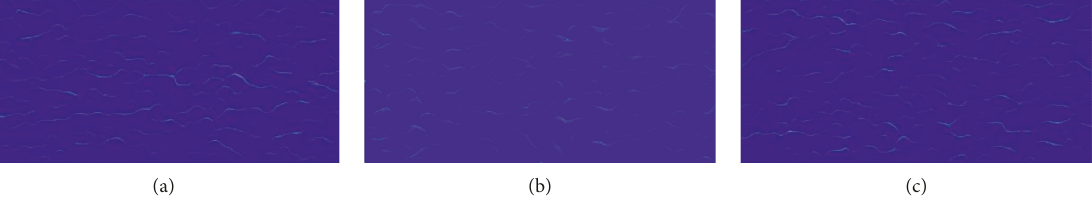
Figure 13: MSST of vibration signals in Figure 12: (a) N, (b) IR, and (c) OR. Table 5: The average accuracy results of the dataset from